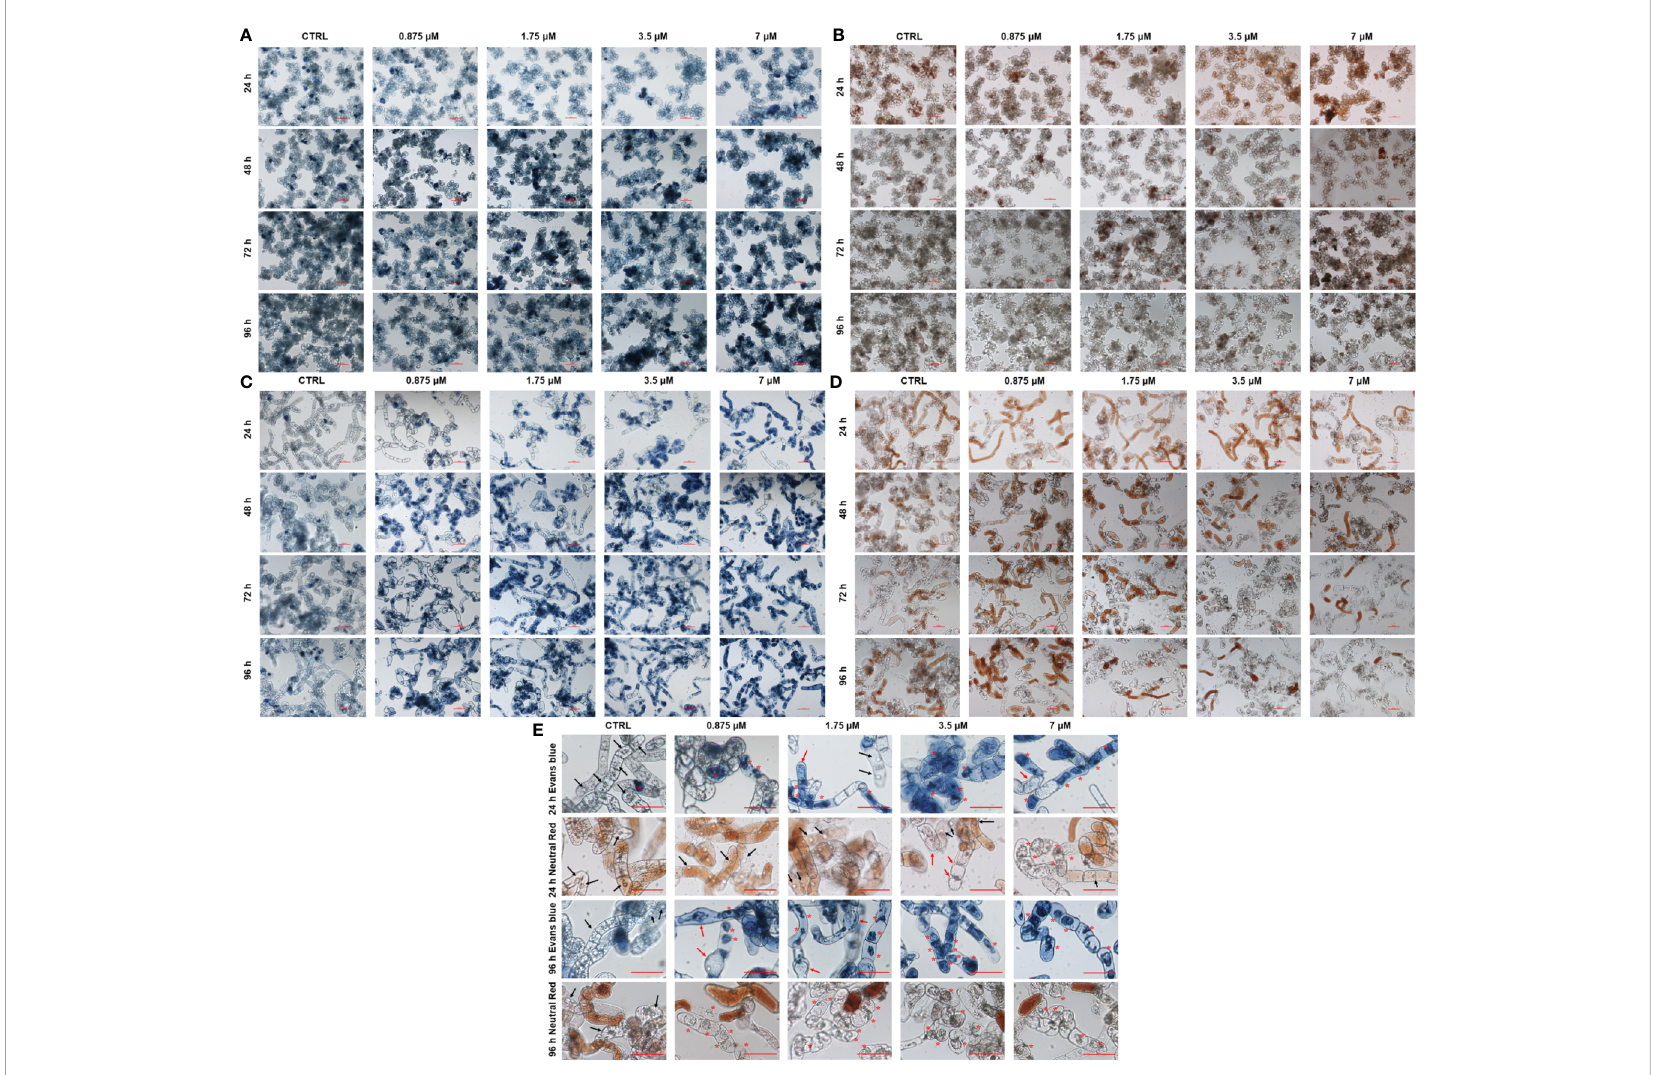
FIGURE 3 Light microscopy images of PSB-D cells (A, B) and BY-2 cells (C, D) stained with Evans blue (A, C) and neutral red (B, D) under a 10x objective. Cells were incubated in the absence or presence of 0.875-7 m M OsRIP1 for 24-96 h. All scale bars indicate 100 m m. (E) BY-2 cells stained with Evans blue and neutral red after 24 h or 96 h of different treatments, respectively. Asterisks (*) indicate vacuolar collapse and cell shrinkage; black arrows indicate normal nuclei; red arrows indicate cell swelling or